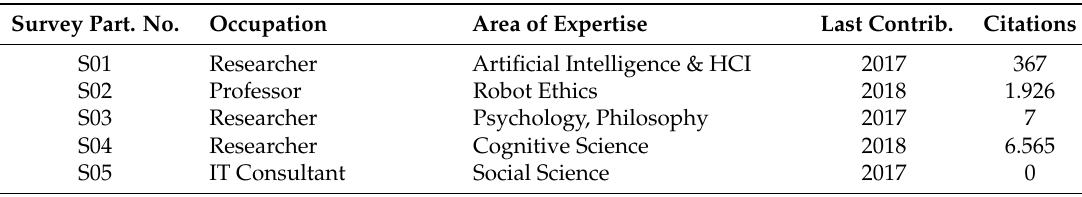
Table 8. Survey participants, their respective areas of expertise and the overall relevance of fields connected to their area of